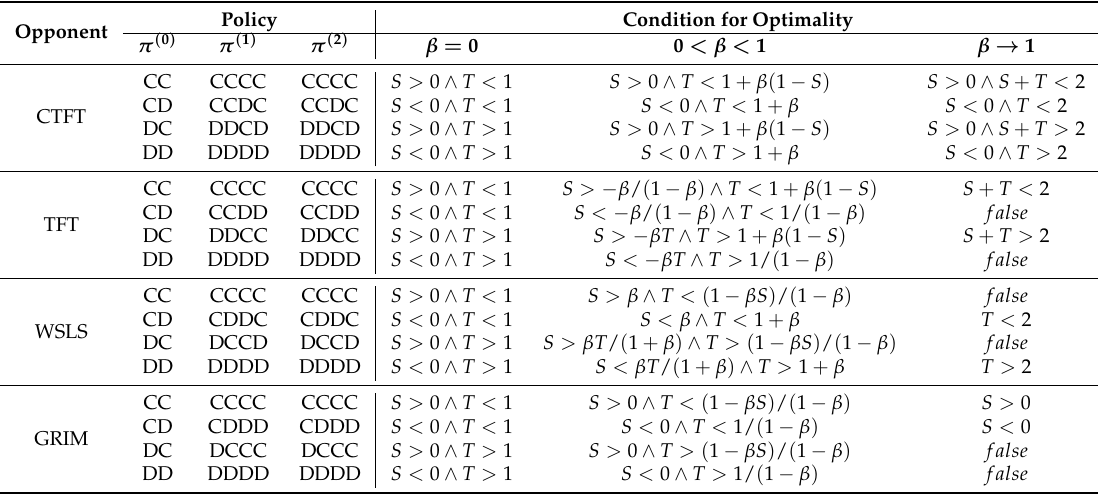
Table 5. Optimal policies and their conditions for optimality (error-free